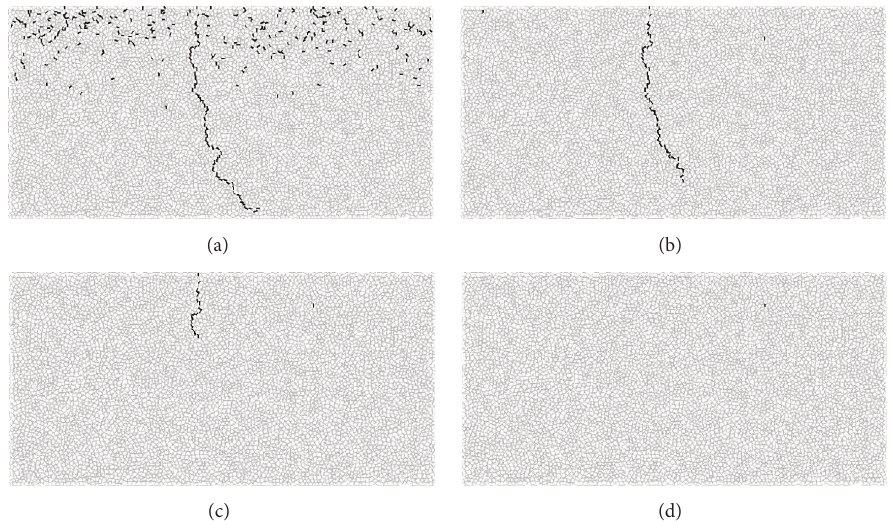
Figure 11: Thermal cracking states of the slab: (a) Case 1, (b) Case 2, (c) Case 3, and (d) Case 4.